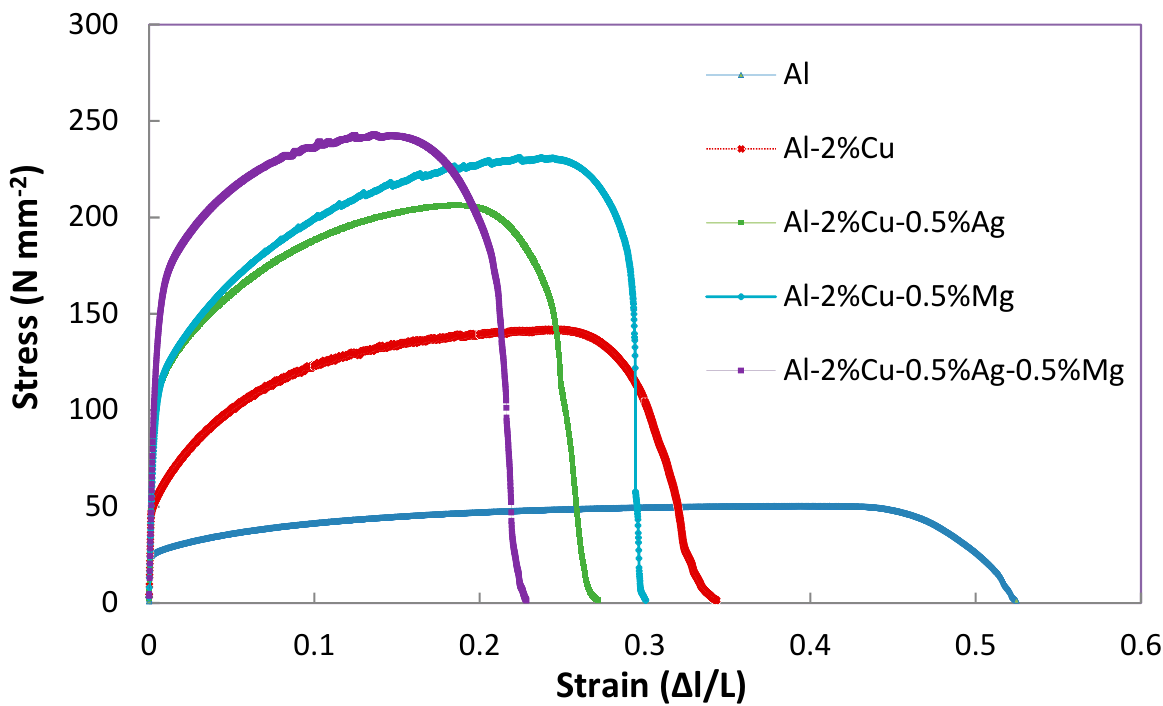
Figure 5. Stress–strain diagram of different alloys in age hardening conditions. Table 3. Yield Strength (N/mm 2 ) values of different heat-treated alloys.